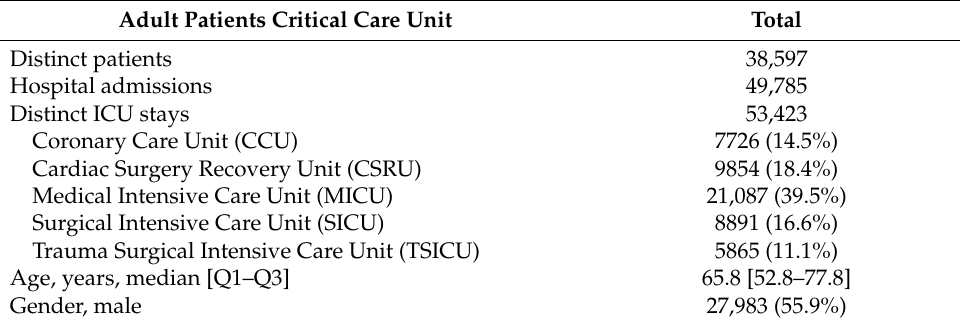
Table 1. Details of the MIMIC-III patient population for patients aged 16 years and